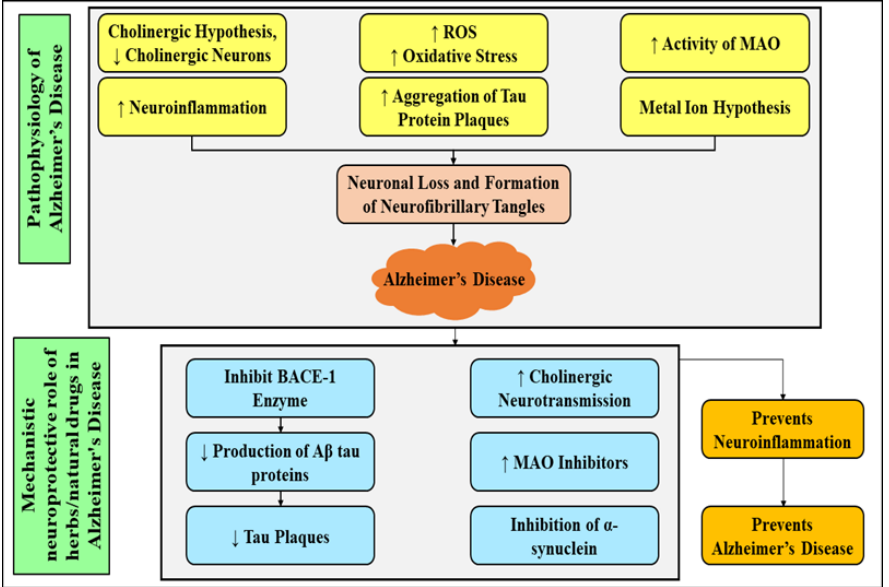
Figure 2. Pathological factors responsible for onset of Alzheimer’s disease. BACE-1: β -secretase; MAO: mono amino oxidase; ROS: Reactive oxygen species.